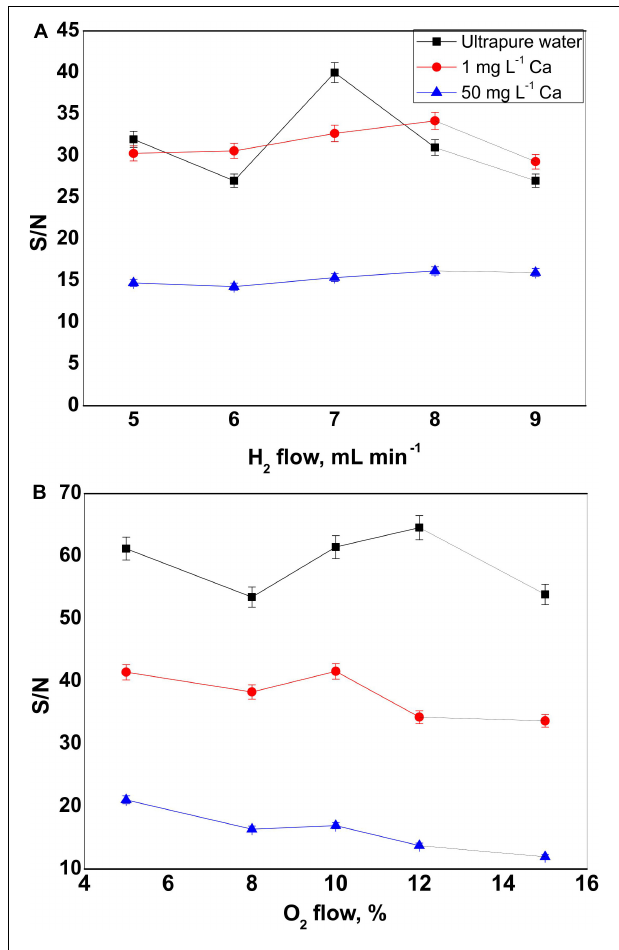
FIGURE 1 | Signal-to-noise ratio obtained for three different matrices: ultrapure water (black line, squares), 1 mg L − 1 Ca (red line, circles), and 50 mg L − 1 Ca (blue line, triangles) at different (A) hydrogen gas flows, and (B) oxygen gas percentages. Error bars represent the standard deviation of the